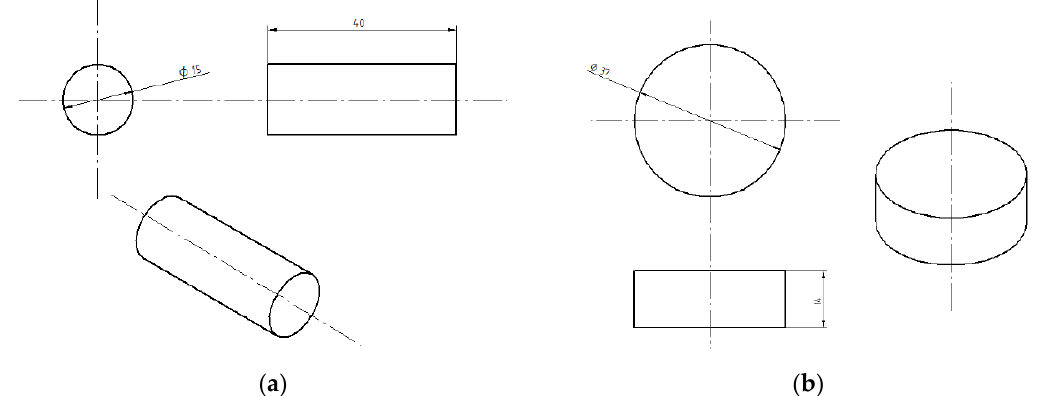
Figure 1. Shape and dimensions of adhesive compounds samples: ( a ) strength test samples; ( b ) microscopic test samples.